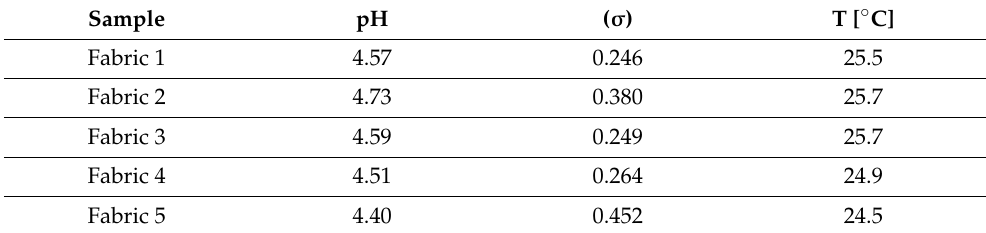
Table 6. pH evaluated by contact